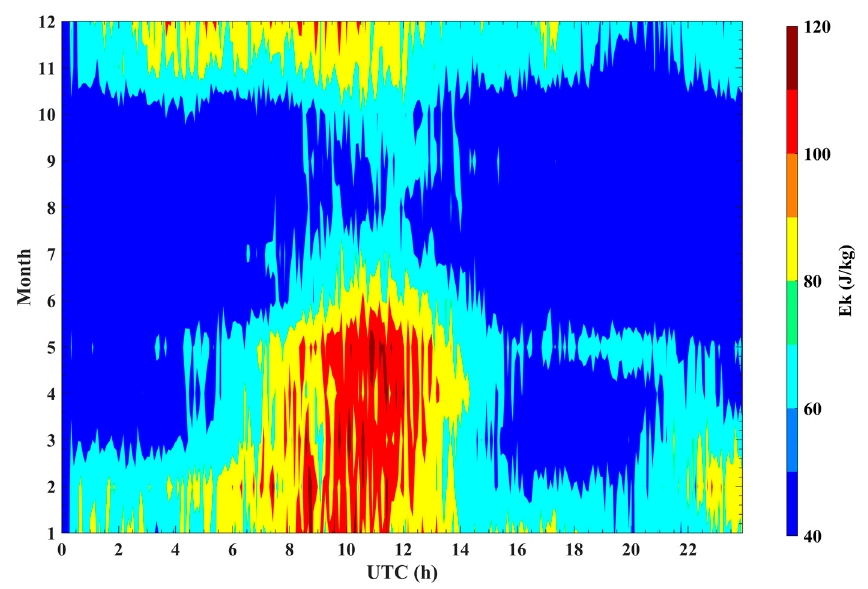
Figure 8. Hour-mouth cross section of GW kinetic energy Ek calculated by 5 min Mohe meteor radar. The estimated energy is averaged over the whole study period.